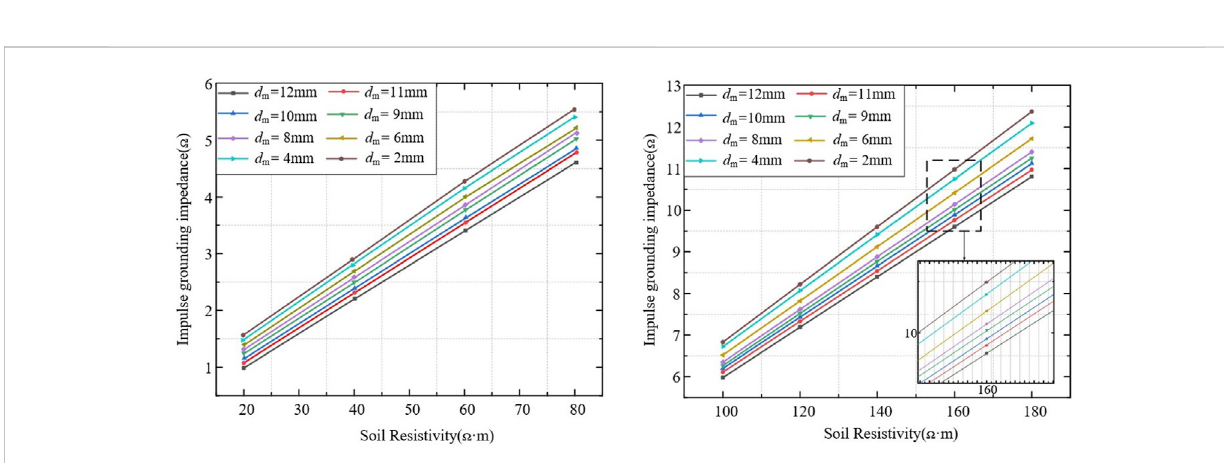
FIGURE 6 Impulse grounding impedance of different corrosion degree: (A) 20 Ω · m ≤ ρ ≤ 80 Ω · m; (B) 100 Ω · m ≤ ρ ≤ 180 Ω ·